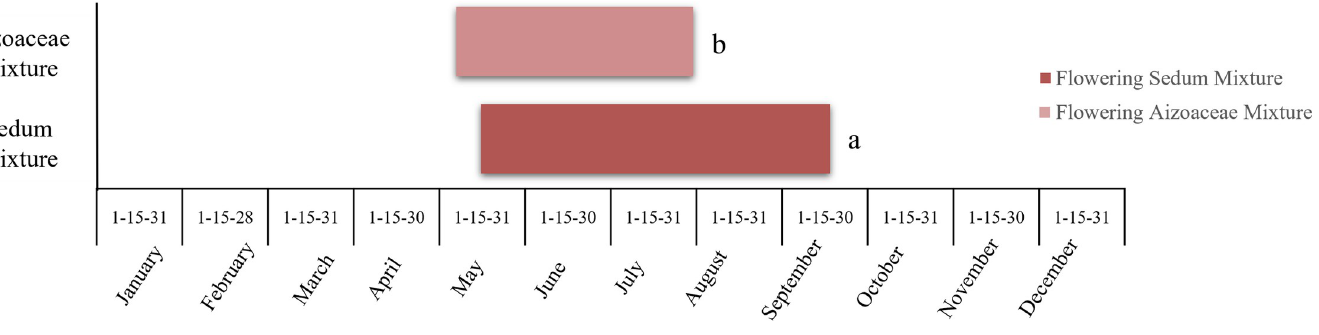
Fig 7. Duration of flowering stage in the two test treatments–Year